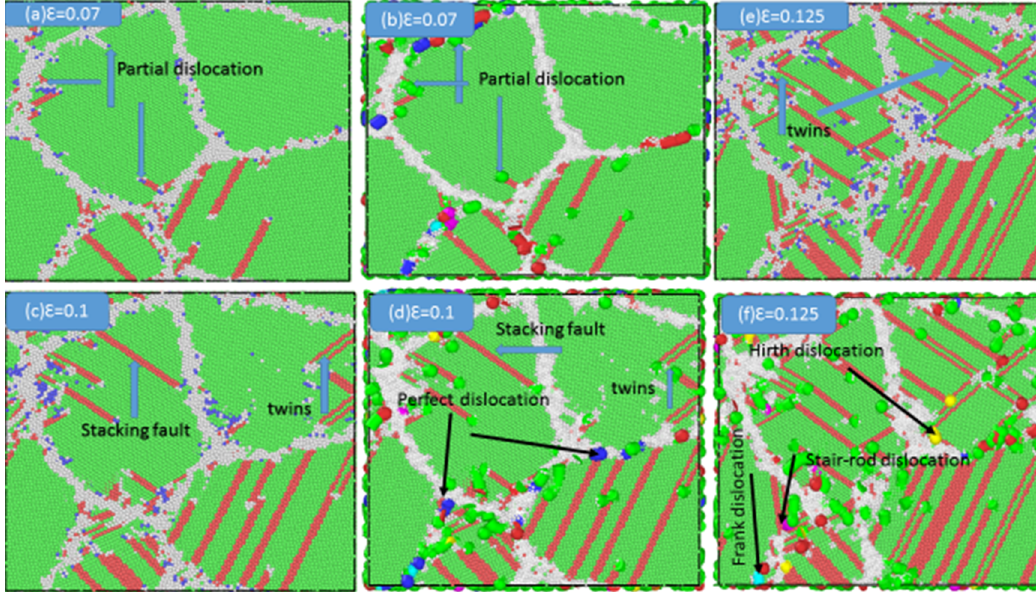
Figure 5. ( a , b ) Emission of partial dislocations from grain boundaries, ( c , d ) stacking faults in the grains, ( e ) twins formed by the emission of partial dislocations from grain boundaries, and ( f ) other types of dislocations for the sample with an average grain size of 9.9 nm under various strains: ( a ) ε = 0.07, ( b ) ε = 0.07, ( c ) ε = 0.1, ( d ) ε = 0.1, ( e ) ε = 0.125, and ( f ) ε = 0.125. The atoms are colored according to the CNA method and Dislocation Analysis (DXA) algorithm.